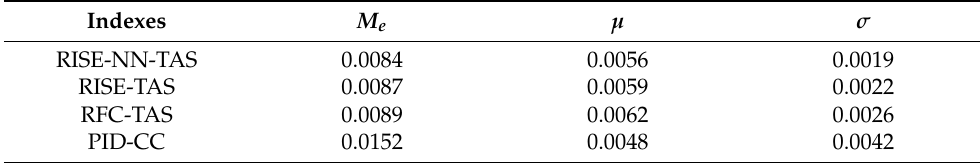
Table 5. Synchronization performance indexes of the four controllers in case